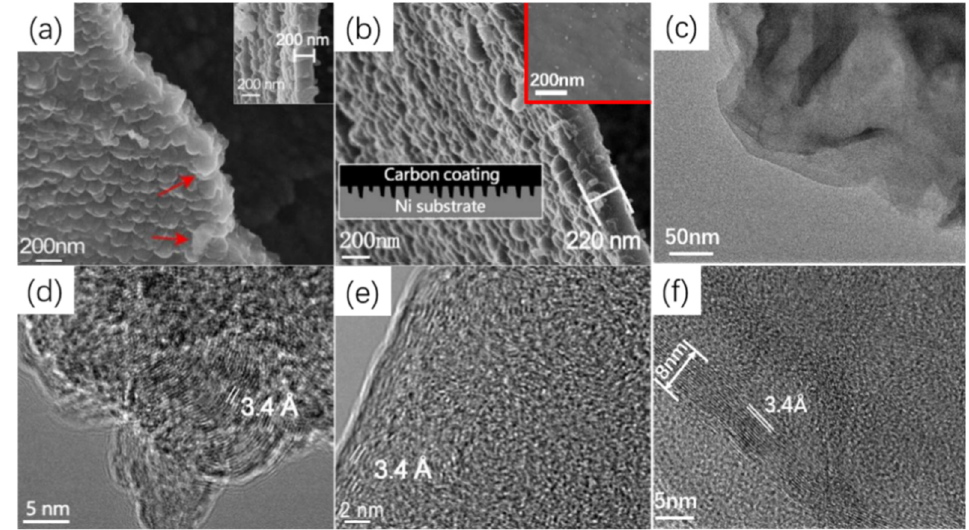
Figure 3. SEM images of the inner surface of ( a ) C-5, ( b ) C-10, insets in ( b ) are the sketch illustrated interlocked interface and the outer surface of C-10, respectively; TEM images of C-10 ( d , e ); TEM images of G-10 ( c , f ).